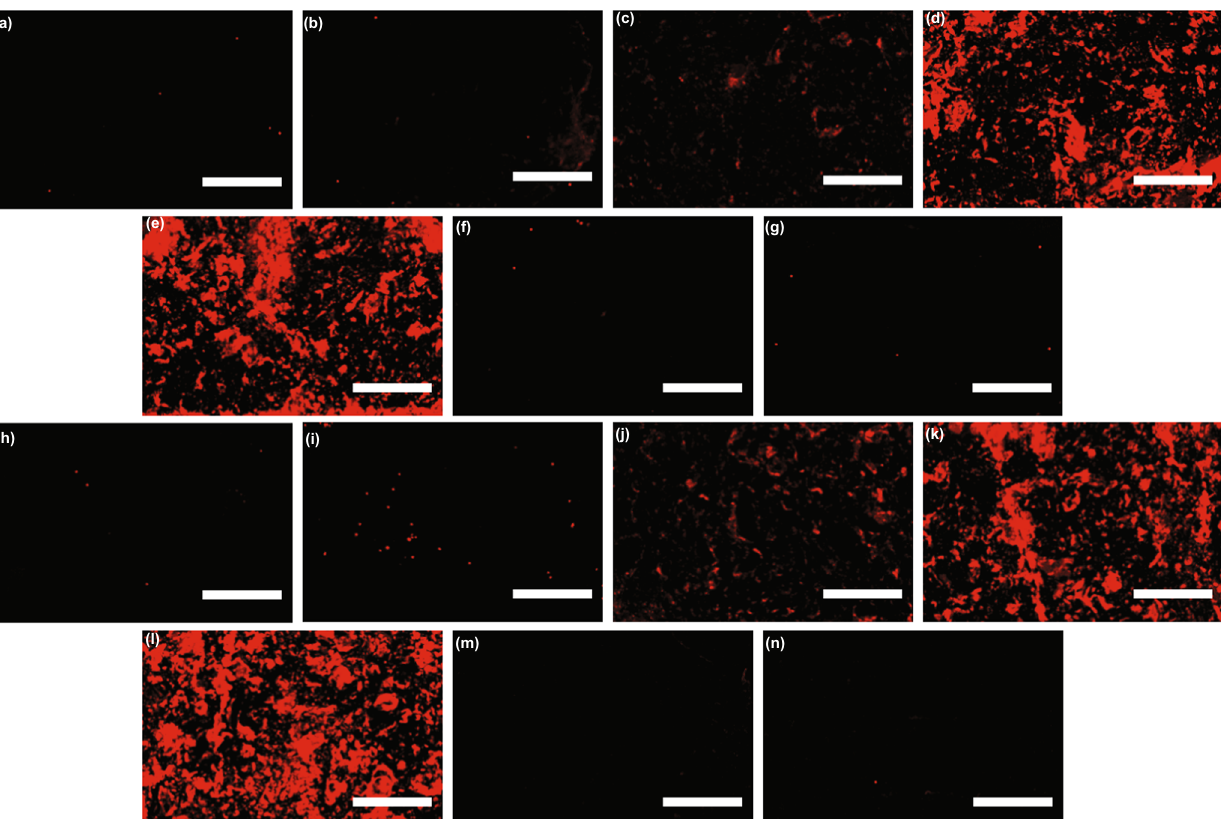
Fig. 3 | Confocal images using red fl uorescent silica nanoparticles. a – g Use fl uorescent Si-NP and h – n uses fl uorescent Si-NP' bothadded directly aftersample incubation. All the images of membranes had anti-ApoAI as the capture antibody exceptfor g and n thathadAnti-ApoB.Theimagesshowthestateofmembranefor samplecontaining a 1pM, b 10pM, c 100pM, d 1nMand e 10nMofPON1-HDLand h 1pM, i 10pM, j 100pM, k 1nMand l 10nMofHDL-P.Aproteincocktailcontaining